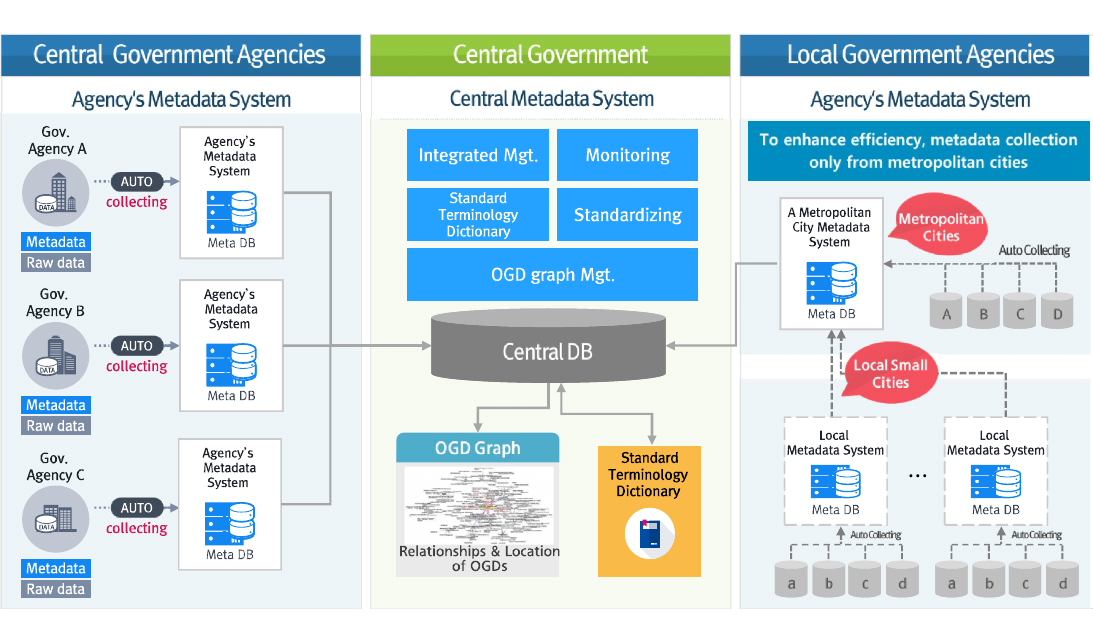
Figure 3. The Process of Metadata